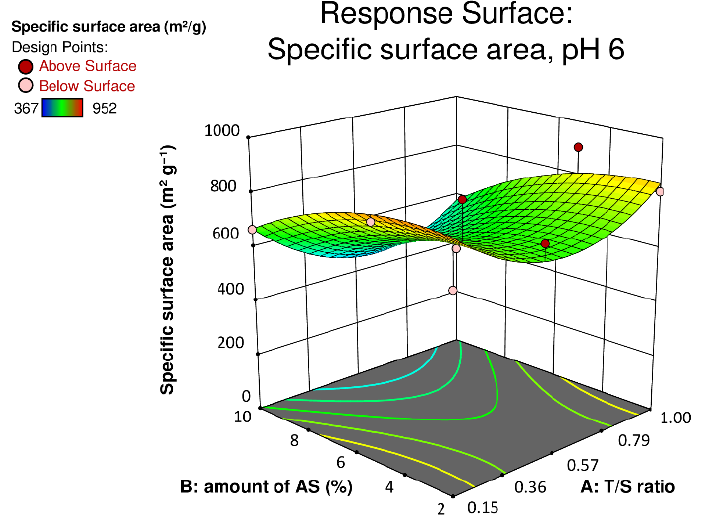
Figure 8. Specific surface area of the tannin-silica hybrid aerogels as a function of their composition at a pH value of 6.